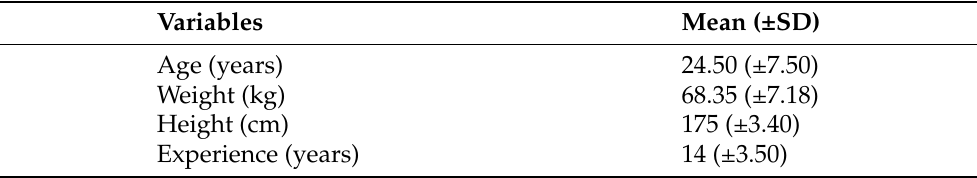
Table 1. Anthropometrics and experience information of the